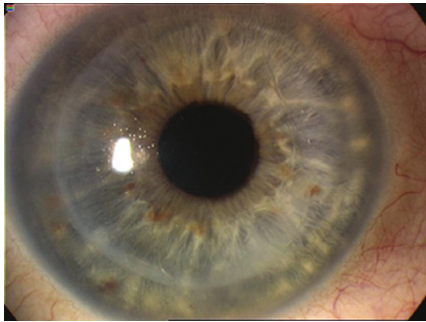
Figure 2: Properly attached DMEK-S